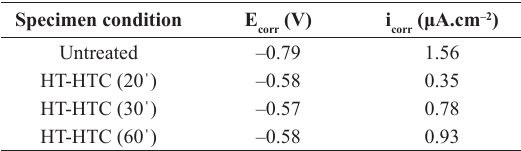
Table 4. Effect of duration of LT-HTC formation on E of uncoated and coated AA 6061 in 0.01 M NaCl. Specimen condition Untreated